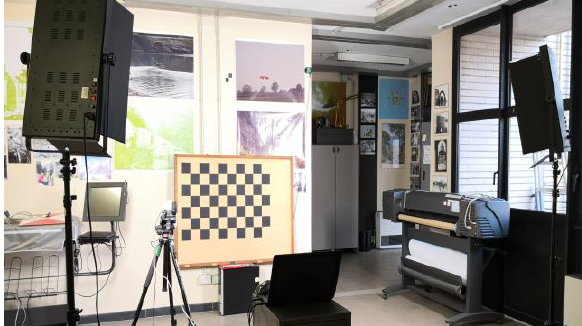
Figure 1. The acquisition of a dataset in indoor environment, considering controlled illumination and exposure values (T2)